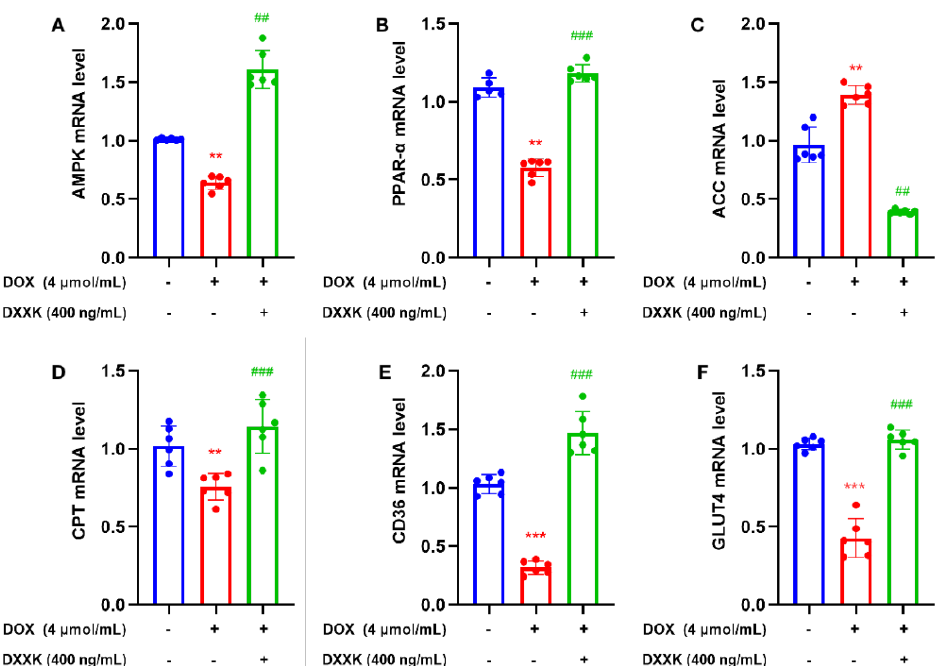
Figure 8. DXXK can promote the expression of key target mRNAs in the myocardial energy metabolism pathway. ( A ) The mRNA level of AMPK. ( B ) The mRNA level of PPAR- α . ( C ) The mRNA level of ACC. ( D ) The mRNA level of CPT. ( E ) The mRNA level of CD36. ( F ) The mRNA level of GLUT4. ** p < 0.01 and *** p < 0.001 compared with the control group. ## p < 0.01 and ### p < 0.001 compared with the DOX group. ” + ” indicates that drugs are added, and “ - ” indicates that drugs are not added.